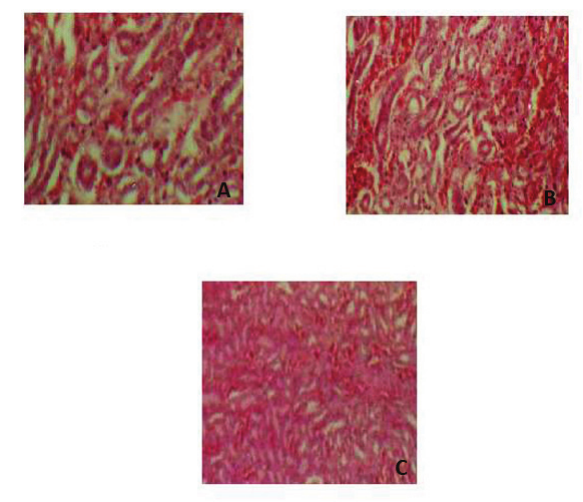
Figure 2. Hematoxylin and eosin (HE) stained kidney section (HE, 200x). ( A ) Mouse kidney section treated intravenously with DON shows inflammation and congestion after 26 hours. ( B ) Mouse kidney section treated intravenously with DON shows congestion and cytoplasmic vacuolization after seven days. ( C ) Mouse kidney section treated orally with DON shows mild inflammation after seven